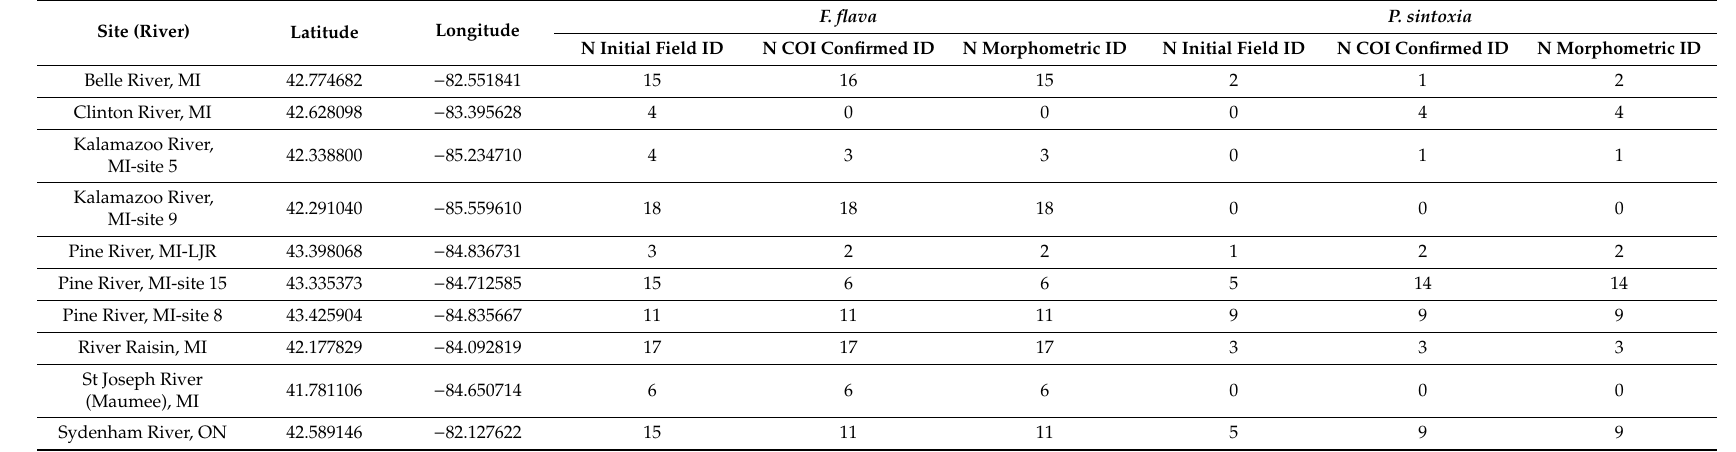
Table 1. Site locations of F. flava and P. sintoxia and numbers field-identified specimens, cytochrome c oxidase subunit 1 (COI)-confirmed specimens, and specimens identified using geometric morphometric analyses (canonical variates